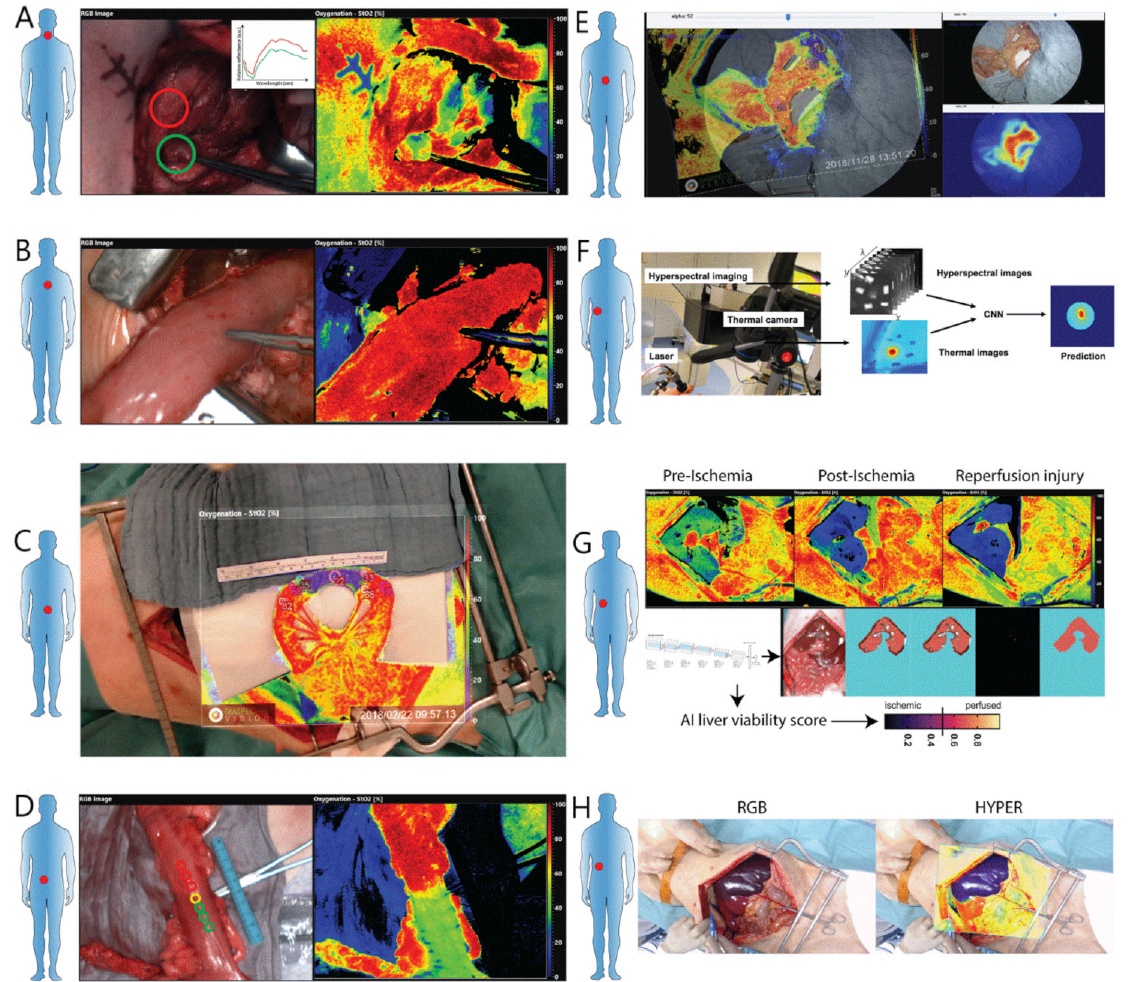
Figure 2. ( A ) Intraoperative HSI picture acquired during human thyroidectomy. In the red circle, thyroid tissue is highlighted, while the parathyroid gland is highlighted in the green one. The false-color image aside shows the perfusion quantification of the oxygen saturation (StO 2 ); the parathyroid gland, highlighted with the forceps has less StO 2 than the surrounding thyroid tissue. ( B ) Intraoperative HSI acquisition displaying the StO 2 assessment of a gastric conduit during human esophagectomy. ( C ) A porcine small bowel ischemia model, in which the mesentery is divided into the middle is shown. The picture shows an example of the HYPER (HYperspectral Enhanced Reality) software, which overlays the HSI perfusion cartography onto the real-time video. This approach facilitates intraoperative navigation by means of HSI. ( D ) HSI acquisition made during human left colonic resection. The proximal resection margin is assessed with HSI. The surgeon set the forceps at the visually determined proximal resection line, obtained after interrupting the organ’s vascular supply. In the HSI-based StO 2 quantification aside, it is visible that the visually determined resection line falls into the marginally perfused area (green) and not into the well-perfused area (red). This example shows that the visual assessment of bowel perfusion is often inaccurate. ( E ) Porcine pancreas partial ischemia model visible in the color picture (top left) with representation of the fluorescence angiography quantification (top right) and HSI-based StO 2 quantification (bottom picture), showing a well-demarcated ischemic area (in blue). ( F ) Experimental set-up of the porcine hepatic thermal ablation monitoring using HSI. The thermal camera and HSI camera are used to train CNNs to predict liver damage induced by laser ablation with a high degree of accuracy. ( G ) Automatic liver viability scoring with deep learning and hyperspectral imaging. CNNs are trained to automatically recognize liver tissue and its perfusion (ischemic 0–perfused 1). During the reperfusion phase, the score predicts the ischemia reperfusion injury and microvascular failure. ( H ) Hyperspectral enhanced reality (HYPER) for anatomical liver resections. HSI images are overlaid over the real-time video to guide liver resection. This approach helps the surgeon to intraoperatively distinguish the non-perfused from the perfused parenchyma in order to guide liver